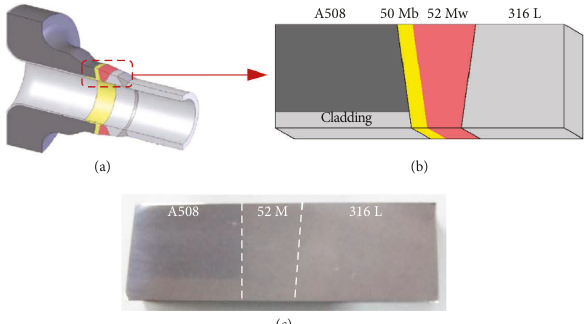
Figure 1: DMWJ at safety end in PWR nuclear power plant. (a) Safety end and sampling position. (b) Three-dimensional geometrical model. (c) DMWJ